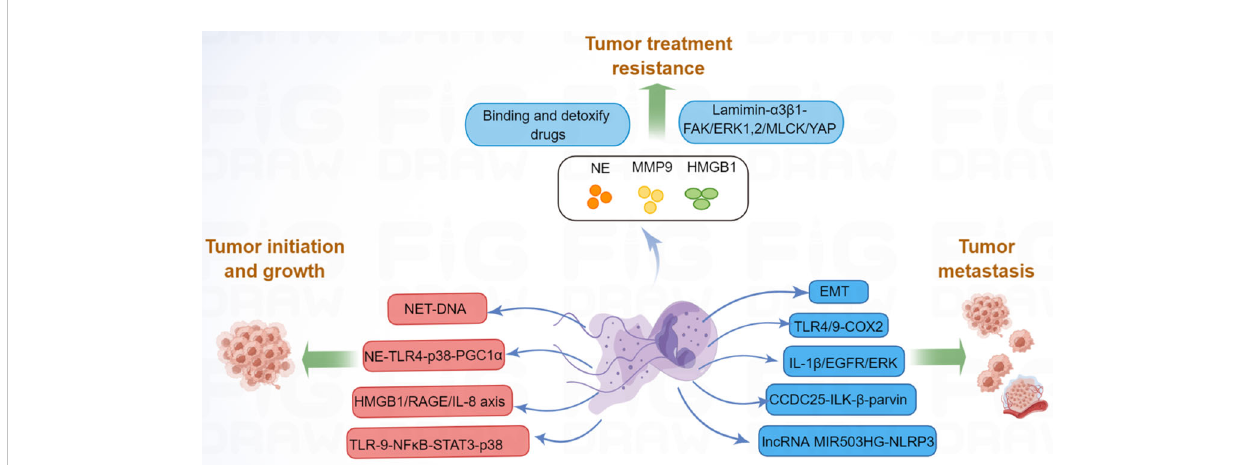
FIGURE 2 NETs promote tumor progression via many molecular pathways. NET can increase tumor cell proliferation by activating TLR9-NF k B-STAT3-p38 pathway; NET-DNA increased MMP-2 and -9 production, which increased tumor growth; NE released by NETs, can enhance tumor growth by activating TLR4-p38-PGC-1 a pathway; HMGB1, released by NETs, can promote tumor growth by RAGE-IL-8 axis. Moreover, NETs promote tumor metastasis by promoting EMT, activating TLR4/9-COX2, IL-1 b -EGFR-ERK, CCDC25-ILK- b -parvin, and lncRNA MIR503HG-NLRP3 pathway. Besides, NETs-associated NE, MMP-9, and HMGB1 contribute to tumor therapy